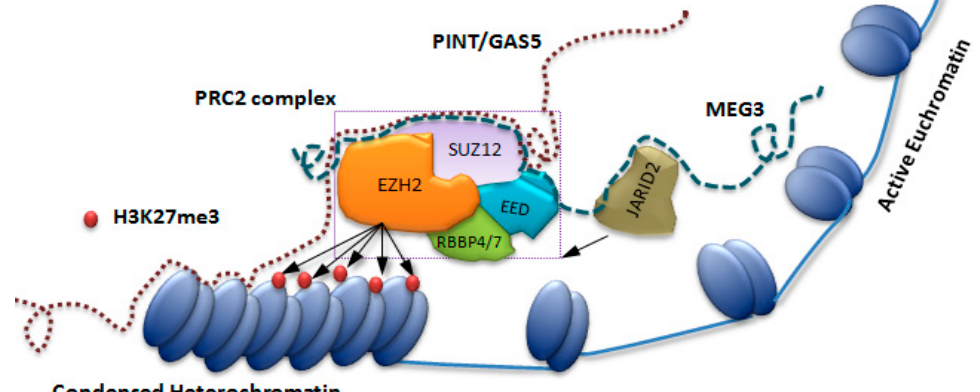
Figure 1. Recruitment of PRC2 complex on the heterochromatin assembly. Assembling the PRC2 components on sequence specific DNA mediated by lncRNAs (MEG3, PINT and GAS5). The PRC2 complex is shown with its core components (EZH2, SUZ12, EED and RBBP4/7) and this is responsible for di- and tri-methylation of nucleosomal histone proteins (H3K27me3). JARID2, a regulatory component of PRC2, interacts with the lncRNA MEG3 (blue dashed line) and helps the recruitment of the PRC2 to the chromatin. The lncRNAs (PINT or GAS5 denoted by the brown dotted line) cobble around the core component of PRC2 and help in its recruitment to the chromatin.